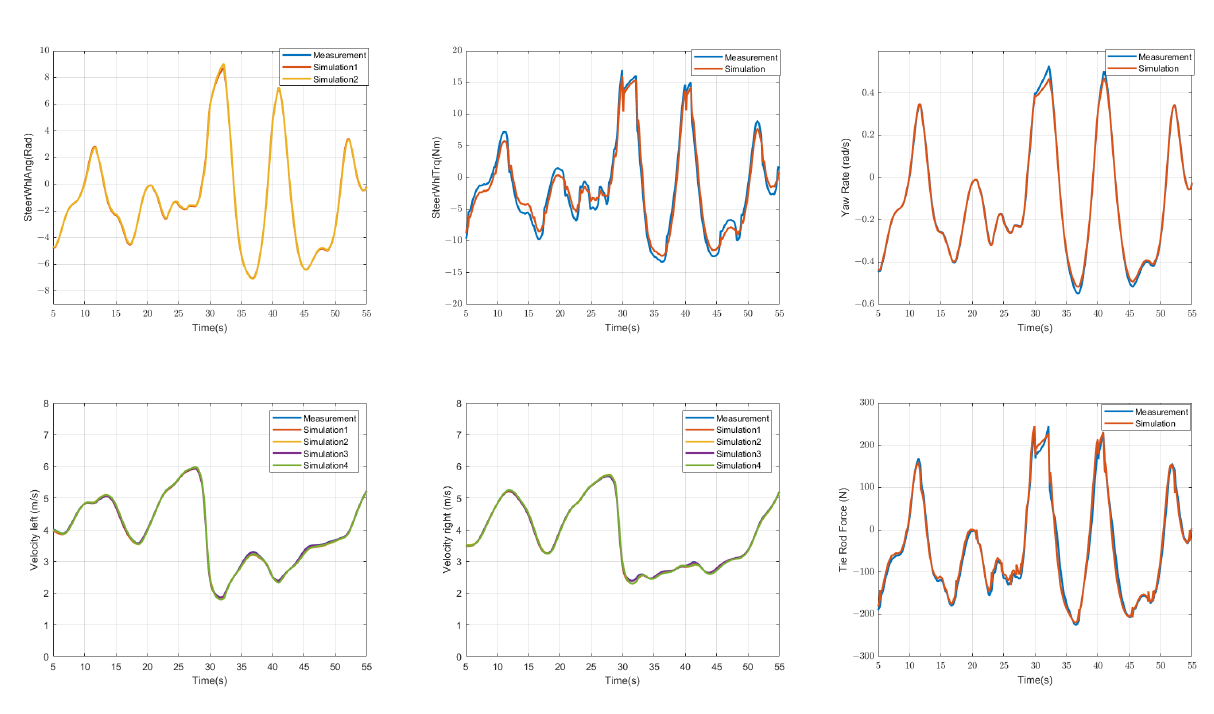
Figure 5. Results of model validation: Comparison of the measured data (blue line) and the simulated data (lines with other colours) of the steering-wheel angle, the steering-wheel torque, the yaw-rate, the left rear wheel velocity, the right rear wheel velocity and the tie-rod